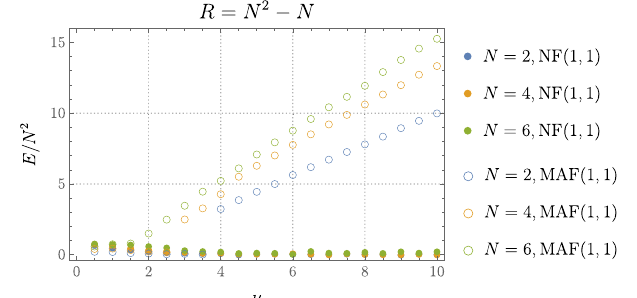
6. Variational energies in the SUSY sector of the mini- BMN model, for different N and ν . Solid dots are initialized